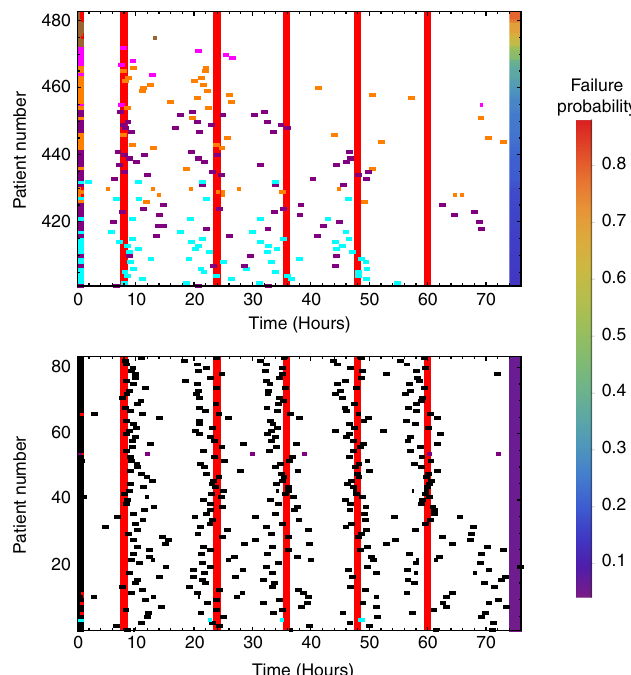
Fig. 4 The time series data recorded by the smart blister packs in ref. 36 . and model-estimated probability of parasitological treatment failure at day 28. Each row represents a patient, with each dose taken marked by a rectangle. Shorter rectangles indicate that the patient did not take the full dose. The rectangles are coloured to indicate the percentage of prescribed pills taken by the patient: all pills (black) between 80 – 99% (cyan), 60 – 79% (purple), 40 – 59% (orange), 20 – 39% (magenta), and < 20% (brown). The vertical, red lines indicate the recommended timings of the six doses. For patients who took multiple pills per dose, we have grouped pills into doses if pills were taken within half an hour of each other. In this fi gure, patients are ordered by the probability that their adherence pro fi le results in treatment failure, according to our within-host model. As the full cohort is large (482 patients), we show two subsets here: the 80 patients with the lowest failure probability (lower panel) and the 80 with the highest failure probability (upper panel). The probability of failing treatment was estimated from 10 4 simulations of the within-host model for each patient adherence pro fi le. The body-weight data, which is needed to inform the PK model, were not available for this cohort, however, the dosing group (the number of pills per dose) is known. Therefore, when running our simulation model for each patient, we average over the weight range (e.g. 5 – 15 kg for the 1 pill per dose group) using a uniform probability distribution. Doses taken after 75 h are not shown here, but their effects are included in the model. The plot for all 482 patients is shown in Supplementary Fig. regimen. To examine this, we simulated removal of doses one by one, starting with the 6th dose, then removing the 5th and 6th,